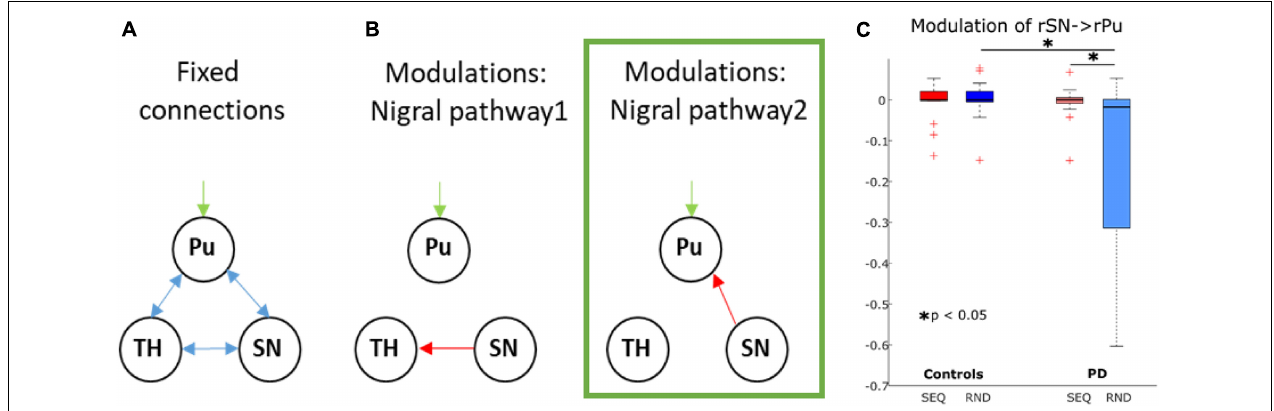
FIGURE 5 | Dynamic causal modeling of the nigro-striatal pathway. (A) Intrinsic connections across all models. (B) Modulatory connections. Pu, putamen; TH, thalamus; SN, substantia nigra. The winning model is marked in green. (C) Boxplots for parameter estimates in the winning model (B) for both groups (PD, controls) and conditions (Sequence, Random). Significant differences are marked with a